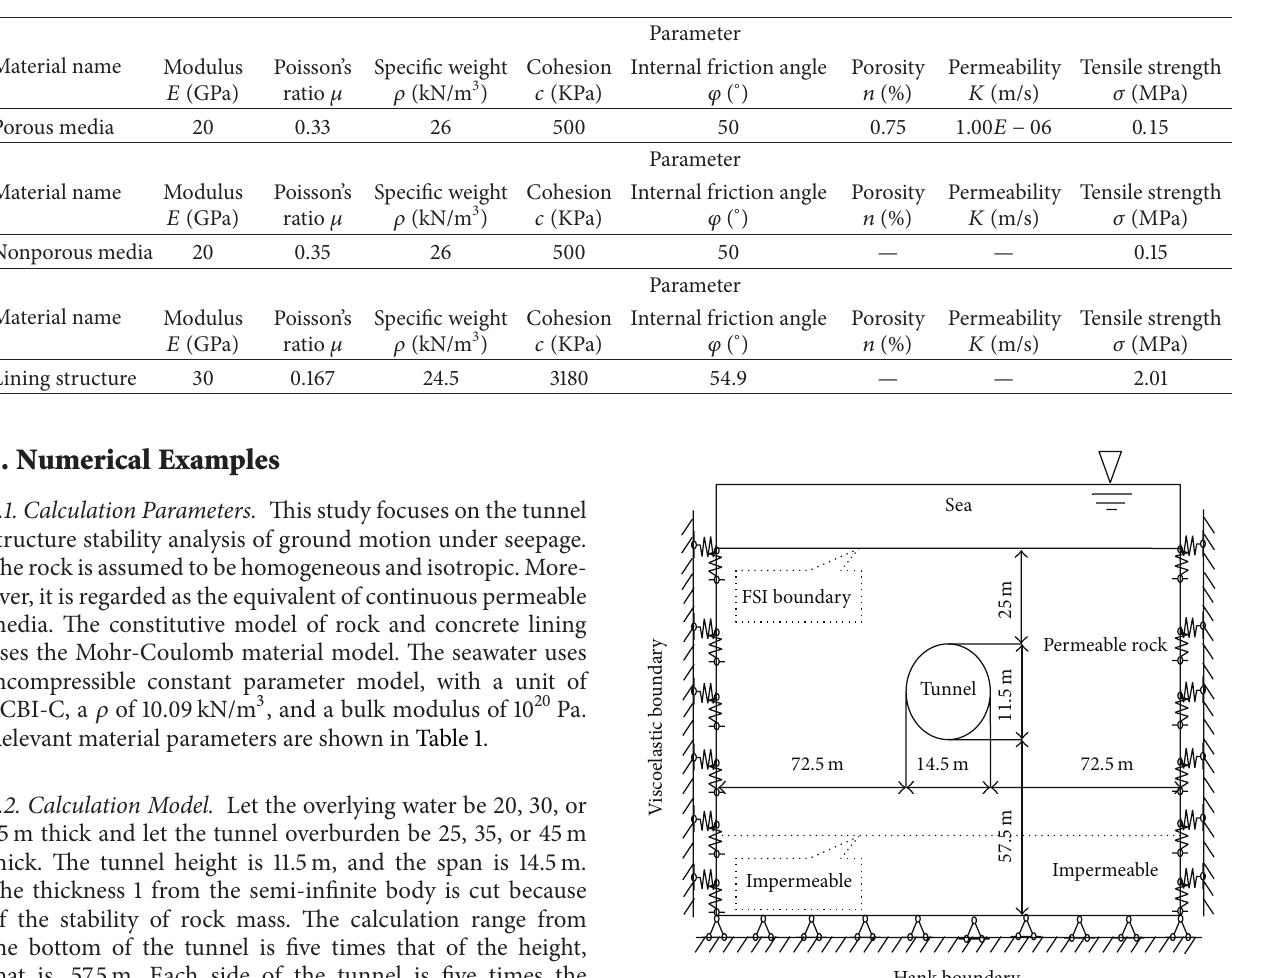
Table 1: Calculation parameters of materials.